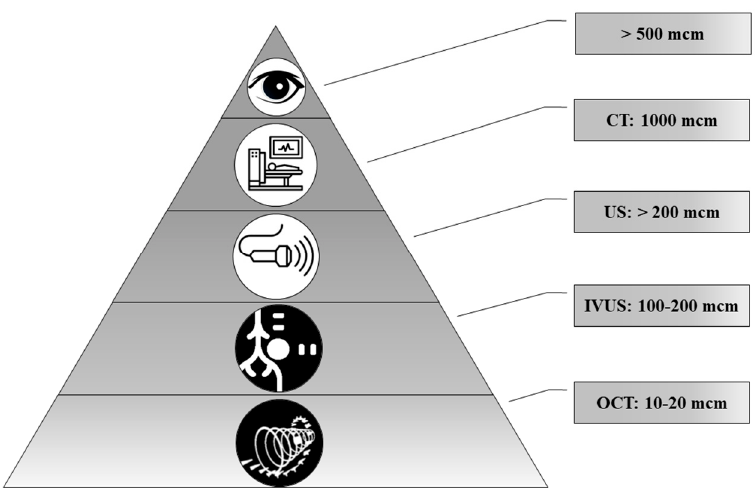
Figure 6. The representation of resolution of diagnostic methods used for biomineral detection.